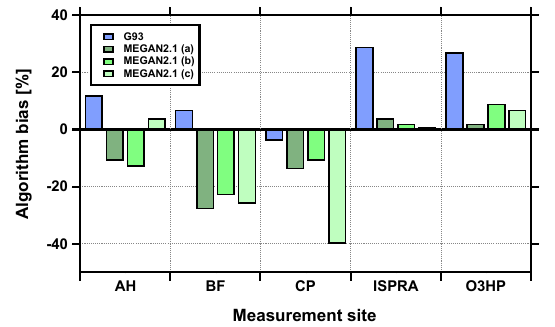
Figure 9. Percentage bias of the average isoprene emission flux sim- ulated by the G93 and MEGAN 2.1 emission algorithms at the five measurement sites, Alice Holt (AH), Bosco Fontana (BF), Castel- porziano (CP), Ispra forest (ISPRA) and the Observatoire de Haute Provence (O3HP), compared to the measured average